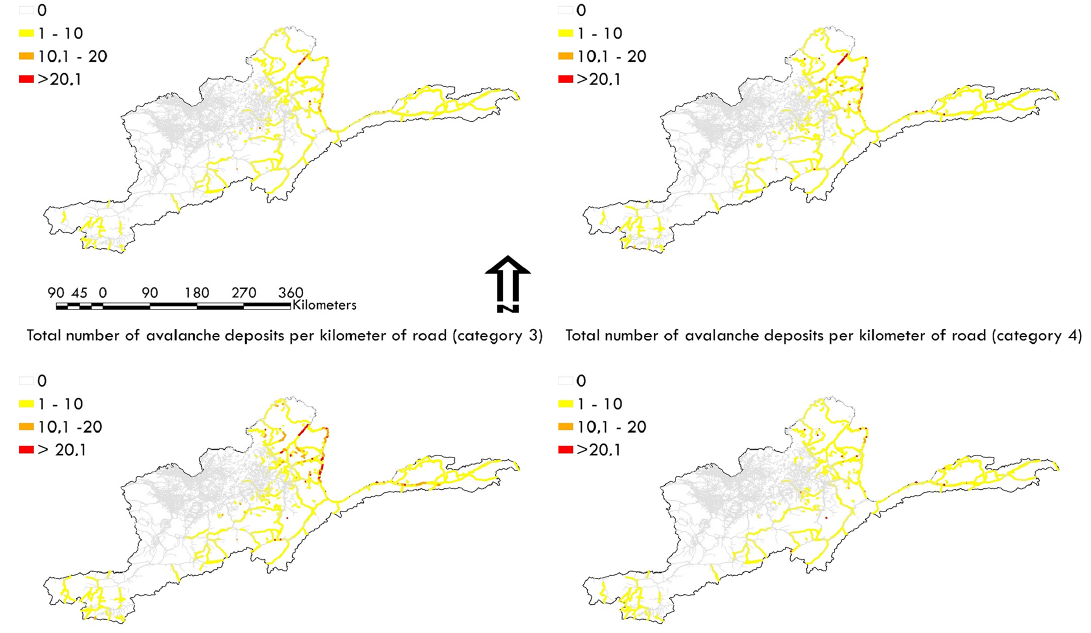
Figure 9. Total avalanche depositional zones per category and per kilometre of roads during the past 32 years.